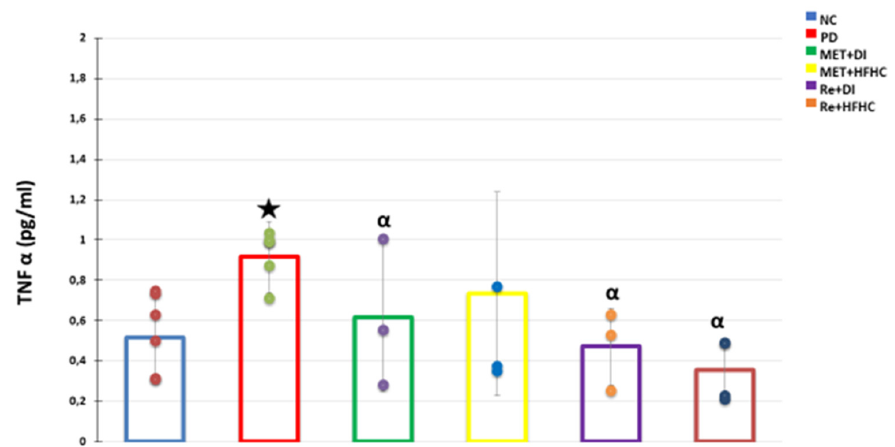
Figure 8. TNF α concentration in normal control (NC), prediabetic control (PD), metformin and diet intervention (MET + DI), metformin and high fat–high carbohydrate (MET + HFHC), rhenium (V) compound and diet intervention (Re + DI) and rhenium (V) compound and high fat–high carbohy- drate (Re + HFHC) groups after 12 weeks of treatment. Values are presented as means ± SD and individual data points ( n = 6). * p < 0.05 by comparison with NC, α p < 0.05 by comparison with PC, MET + DI, MET + HFHC, Re + DI and Re + HFHC.